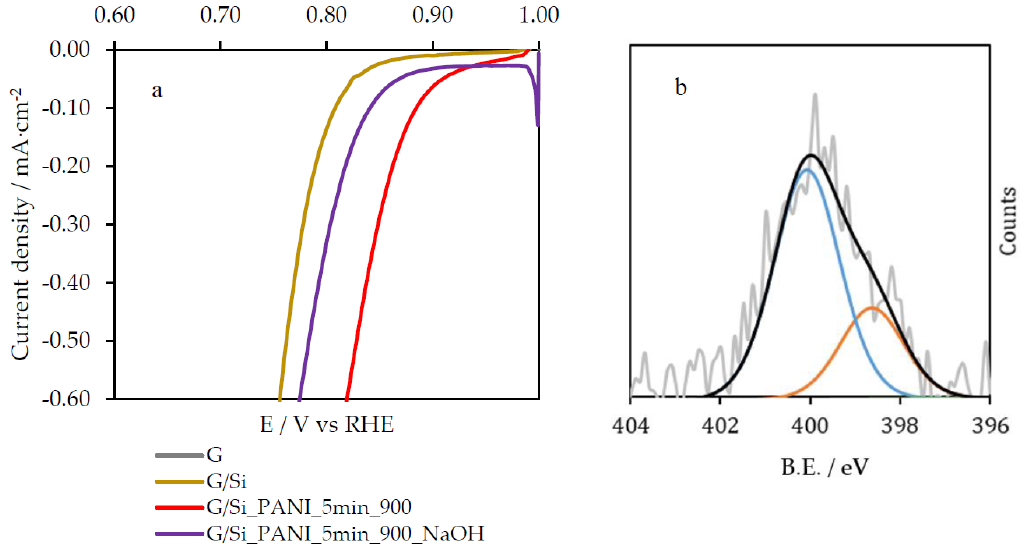
Figure 7. ( a ) Linear sweep voltammetry curves of G/Si_PANI_5min_900_NaOH in O 2 -saturated 0.1 M KOH solution at 50 mV·s −1 and ( b ) N1s from XPS analysis of G/Si_PANI_5min_900_NaOH; blue peak represents pyridonic-like groups and orange line represents pyridine species.